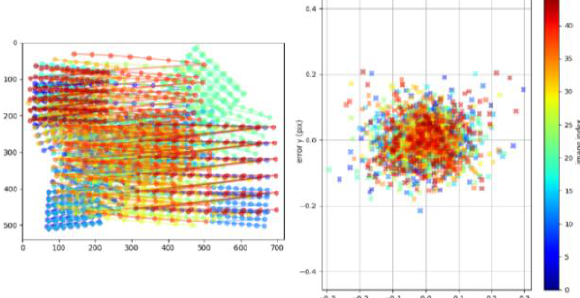
Figure 6: Detected checkboard tie points (left) and their reprojection errors (right) for internal parameter calibration: example of a left Basler stereo